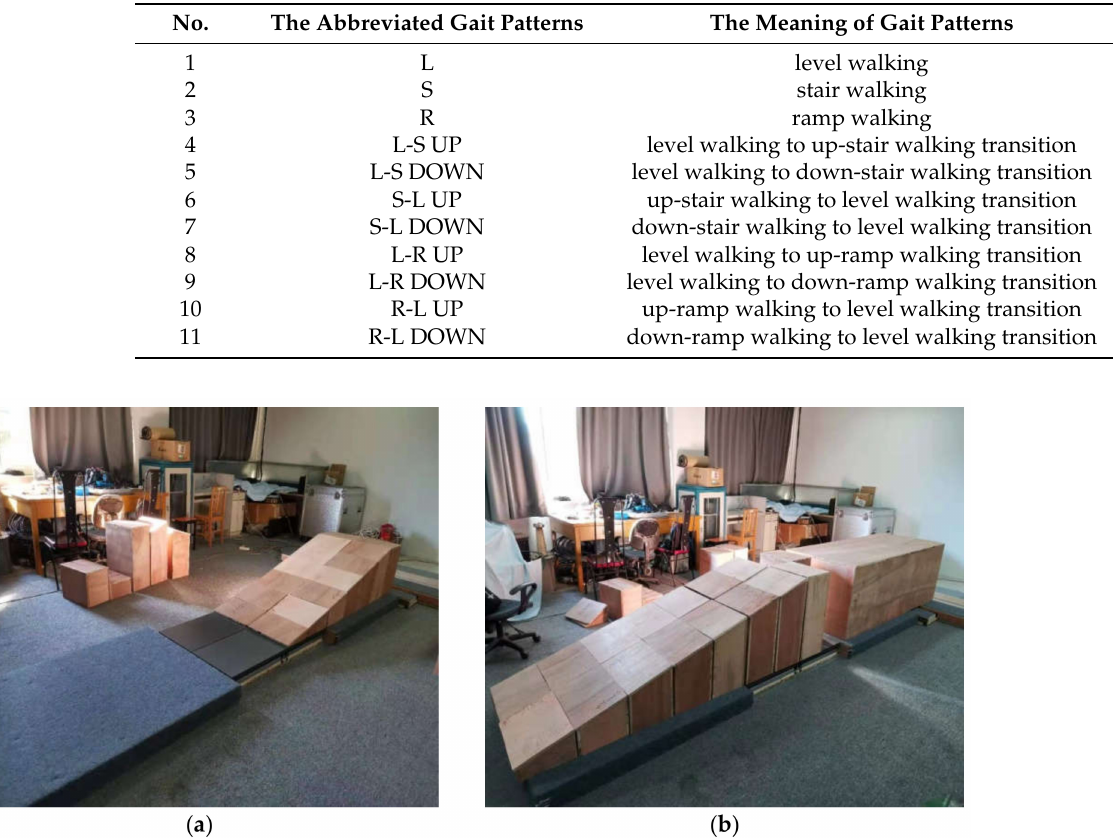
Table 1. The abbreviation of gait patterns.